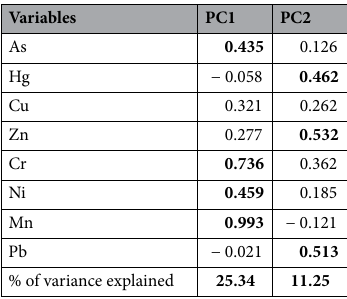
Table 8. Rotated principal component analysis for heavy metals. Significant values are in bold.